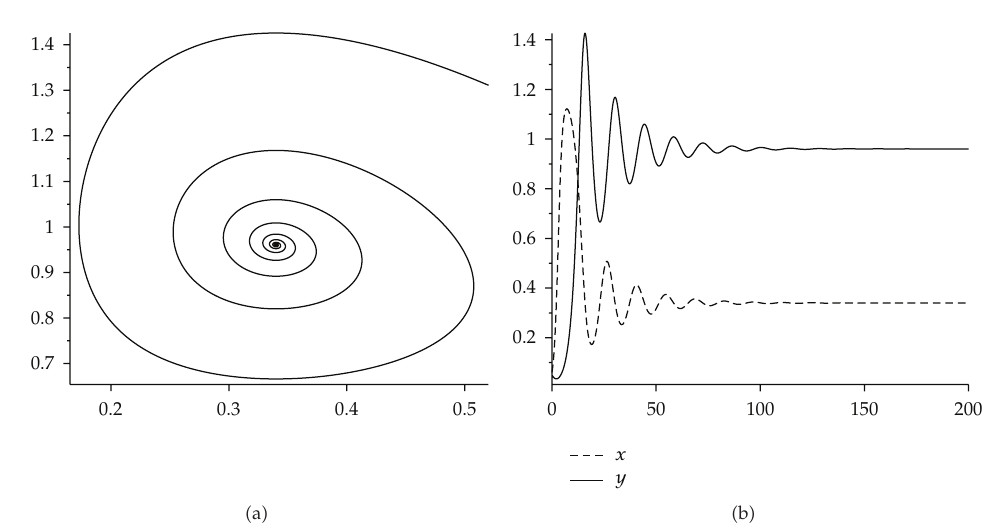
Figure 2: (cid:9) a (cid:10) Phase diagram of system (cid:9) 1.3 (cid:10) without impulses; (cid:9) b (cid:10) time series in x and y of system (cid:9) 1.3 (cid:10) without